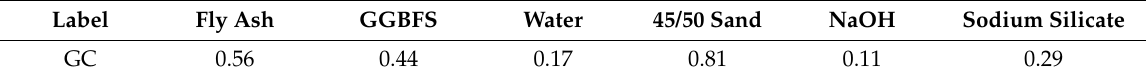
Table 3. Composition of the control mix.